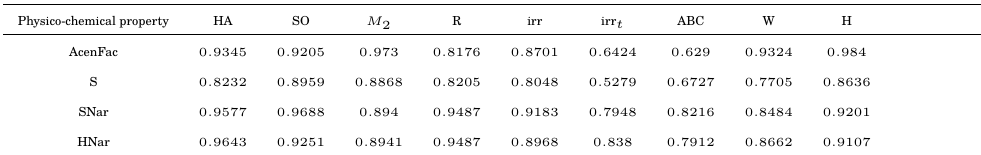
Table 2: The square of correlation coefficient of different topological indices with AcenFac, S, SNar and HNar. Physico-chemicalproperty